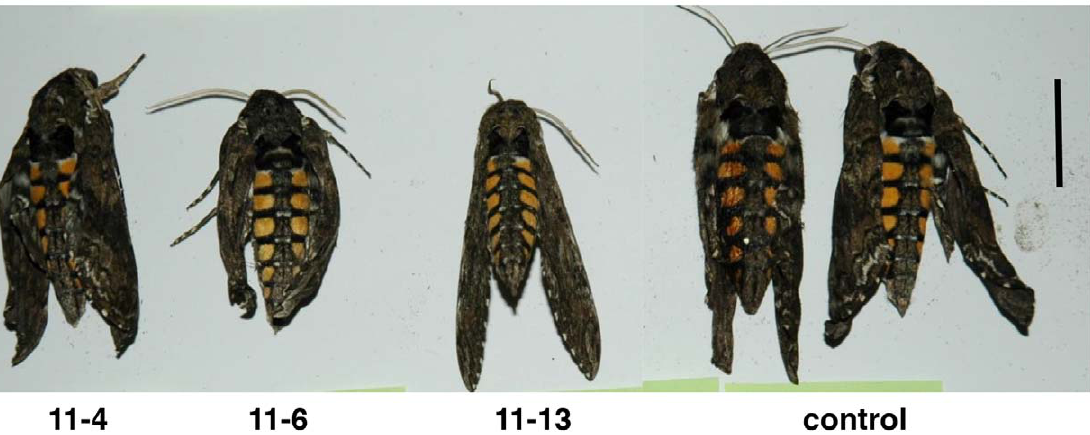
Figure 6. Tobacco hornworm moths after feeding on N.benthamiana plants transformed with the BvSTI gene. Transformant 11-4, 11-6 and 11-13 and untransformed normal control plant. Bar corresponds to 2 cm.